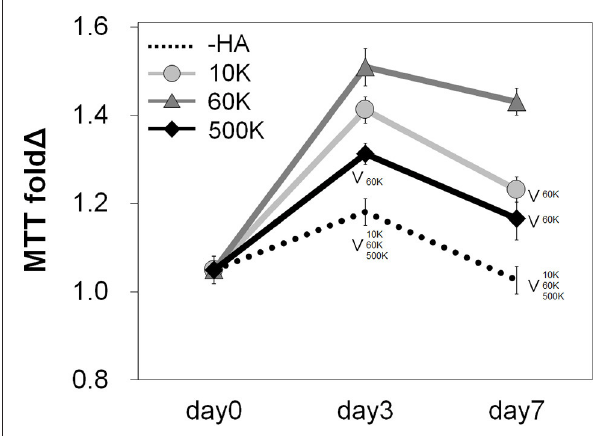
FIGURE 2 | Overall metabolic activities ( n 3) of GBM seeded GelMA = hydrogels as a function of incorporated hyaluronic acid molecular weight. Results are provided throughout the 7-day culture and are normalized to the metabolic activity of each group at day 0. Samples containing matrix-bound HA showed an overall higher metabolic activity compared to GelMA only (–HA) hydrogels. The greatest metabolic activity was observed for GelMA hydrogels containing 60 kDa (60K) HA. ∨ p < 0.05 significant decrease between